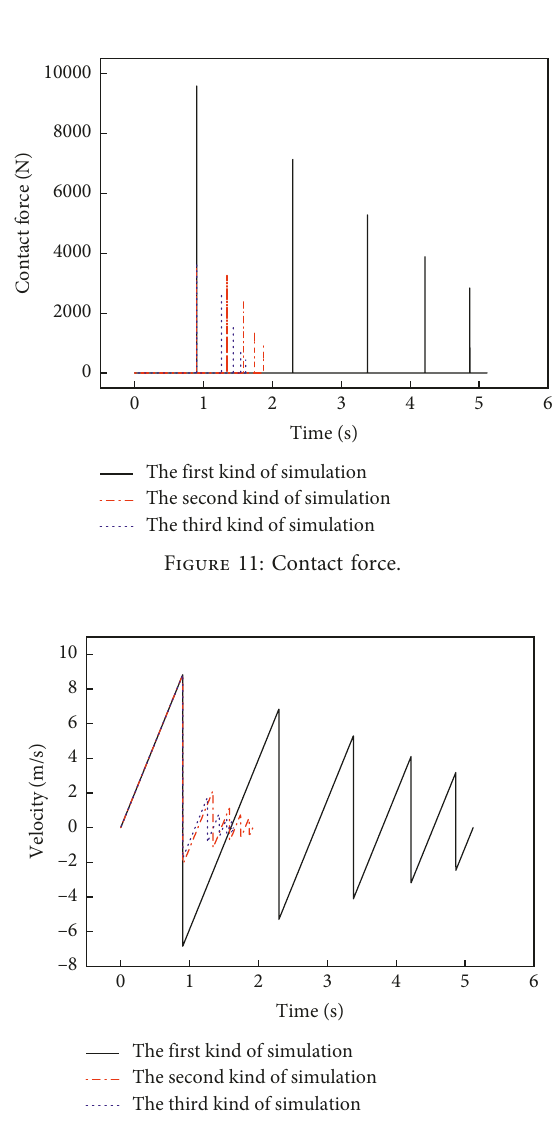
Figure 12: Velocity of centroid mass.